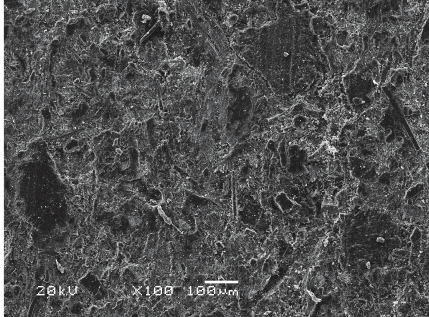
Figure 9: SEM picture of the staved micro-convex-apices.